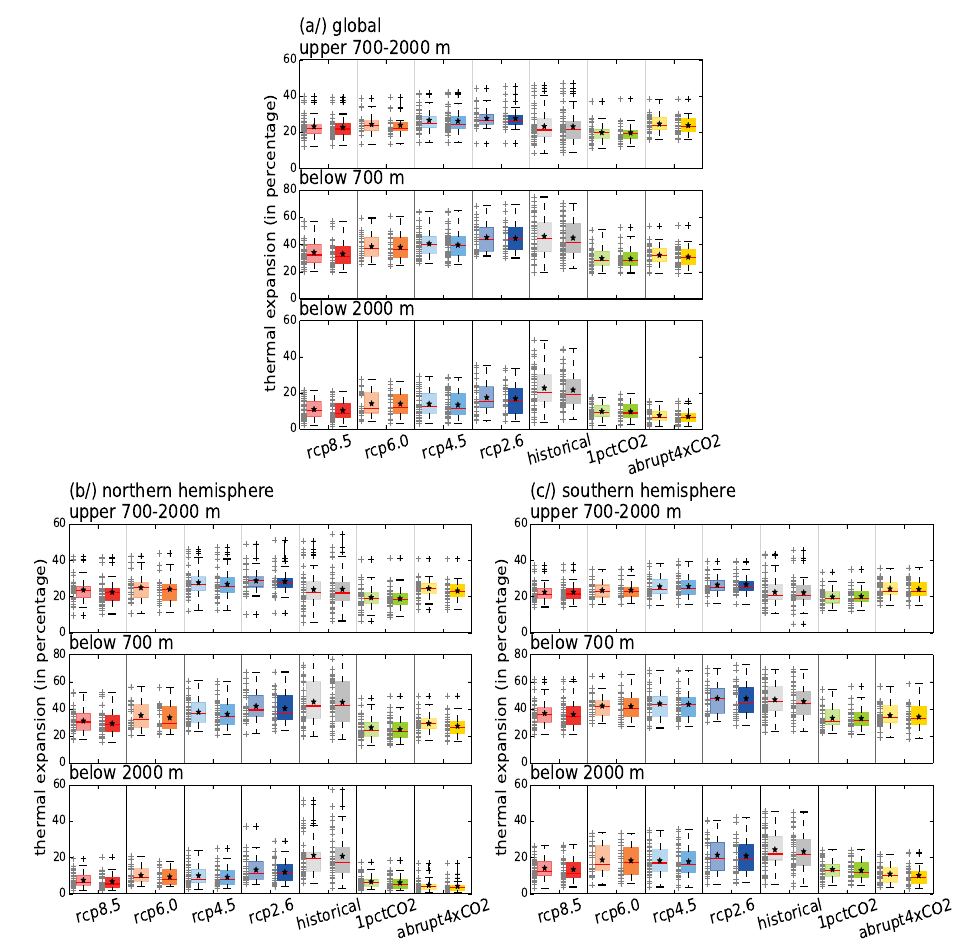
Figure 4. Whisker plots of percentage thermal expansion from the layers between 700 and 2000m, below 700m and below 2000m, re- spectively, relative to the total thermal expansion integrated over the entire water column, for seven scenarios. Thermal expansion estimates are derived from Eq. (2) (left bar) and Eq. (3) (right bar) used in simpler climate models (here with the optimized calibration parameters in Table S2) and are based on (a) globally, (b) northern and (c) southern hemispherically averaged vertical potential temperature profiles, followed by a temporal averaging over the entire time series (see Fig. 3). Bars and whiskers represent the 25–75 and 5–95% uncertainties of the median, respectively; the central mark of the bar indicates the model median, the asterisk the model mean. The number of models available for these statistical estimates are crosses on the left of the box, at which crosses above and below the whiskers indicate model